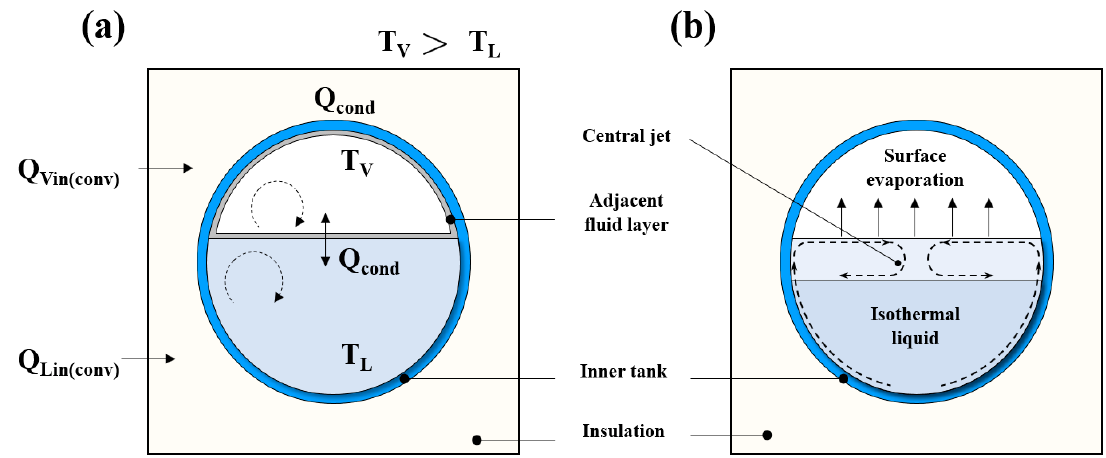
Figure 3. Schematic diagram of ( a ) heat transfer model, ( b ) hydrodynamic model.